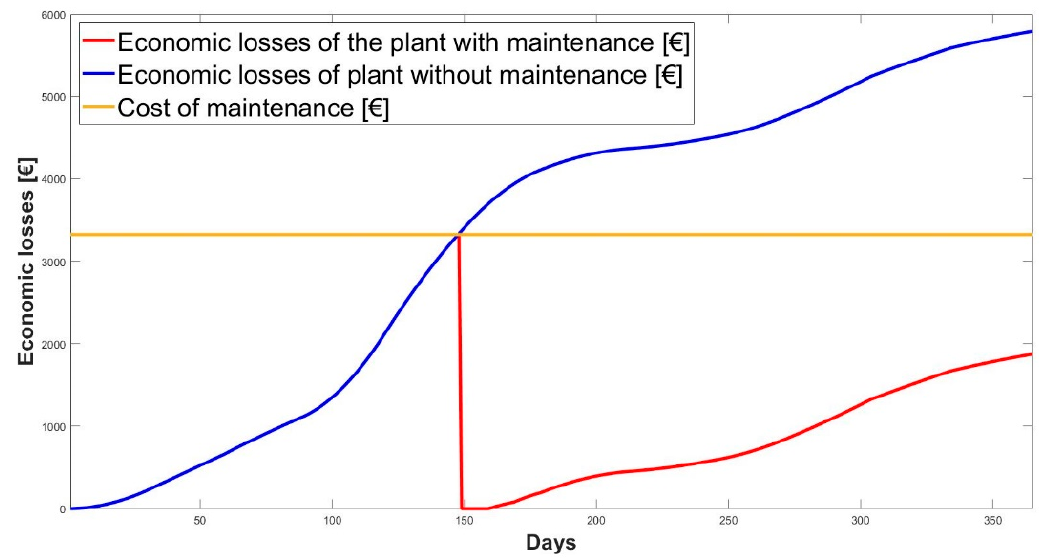
Figure 19. Optimal cleaning interval for the 1 MWp plant from an economic standpoint.